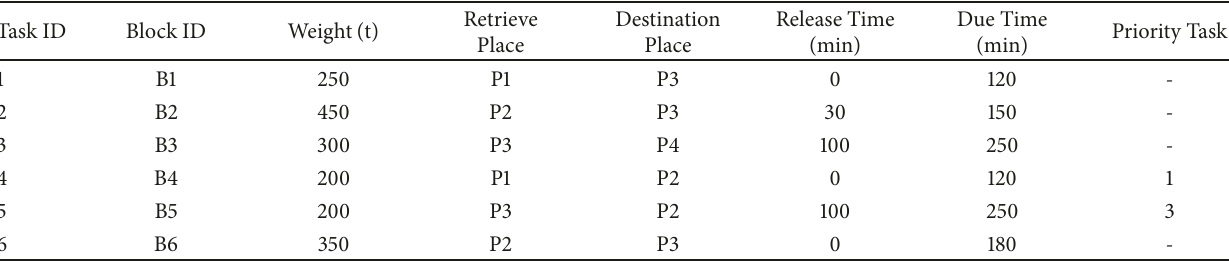
Table 1: Block transportation tasks.